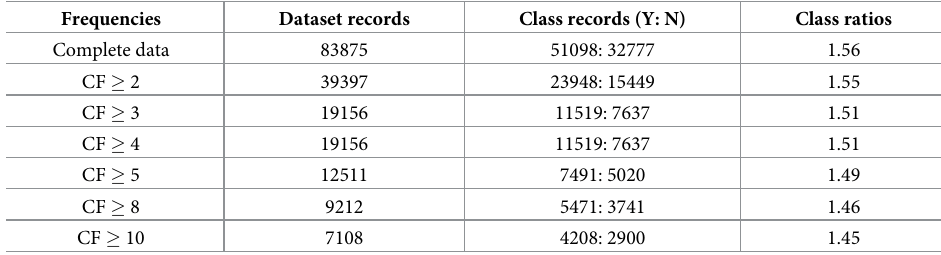
Table 3. Dataset records, class records, and class ratios in the experimental datasets.